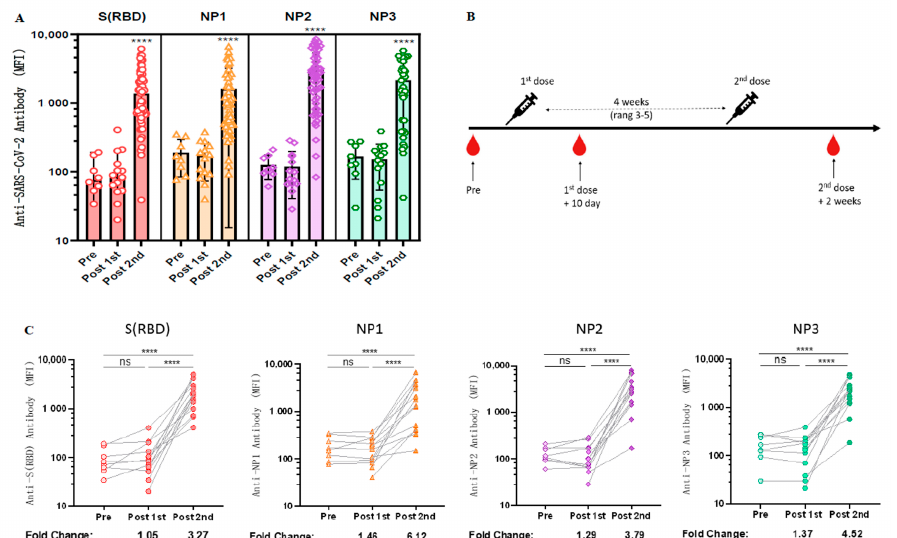
Figure 2. Longitudinal observation of dynamic changes in anti-RBD antibody levels after CoronaVac vaccination. ( A ) Negative sera ( n = 8), serum samples after the first dose of CoronaVac ( n = 14), and serum samples after two doses of CoronaVac ( n = 55) were tested for anti-RBD IgG and anti-NP IgG levels using the Luminex technique. ANOVA was applied to test whether the differences were statistically significant. ( B ) Schematic diagram of the timing of vaccination and peripheral blood sampling. ( C ) Dynamic changes in the antibody immune response to anti-SARS-CoV-2 in serum samples ( n = 14) from the cohort vaccinated with CoronaVac. MFI values were logged and analyzed for statistical significance using paired t-test. **** p < 0.0001.